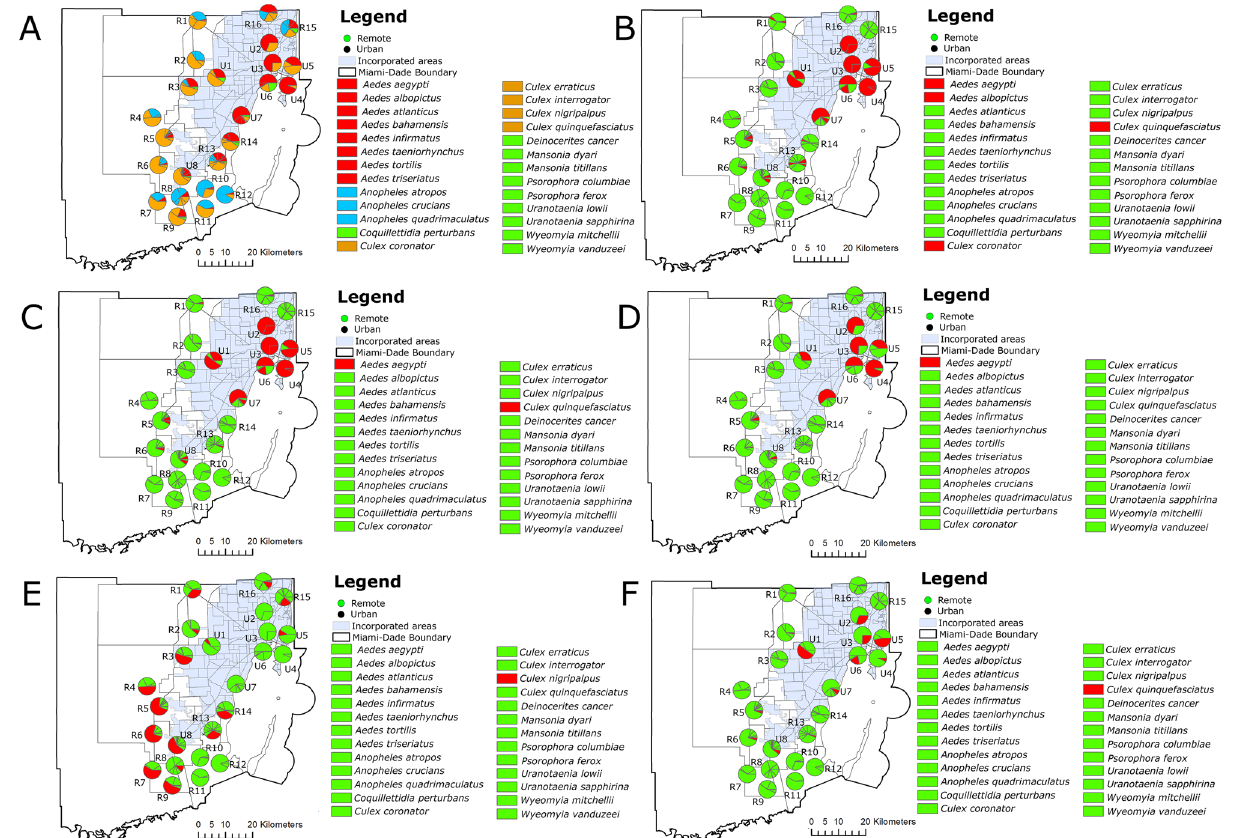
Figure 3. Percent composition of vector mosquito species in remote and urban collection site locations in Miami-Dade County, Florida. Species were organized by ( A ) red = Aedes , blue = Anopheles , yellow = Culex , green = Coquillettidia , Deinocerites , Mansonia , Psorophora , Uranotaenia , and Wyeomyia ; ( B ) red = Aedes aegypti , Aedes albopictus , Culex coronator , and Culex quinquefasciatus , green = all other species; ( C ) red = Aedes aegypti and Culex quinquefasciatus , green = all other species; ( D ) red = Aedes aegypti , green = all other species; ( E ) red = Culex nigripalpus , green = all other species; and ( F ) red = Culex quinquefasciatus , green = all other species. The figure was produced using ArcGIS 10.2 (Esri, Redlands, CA), using freely available layers from the Miami- Dade County’s Open Data Hub—https:// gis- mdc. opend ata. arcgis. com/.